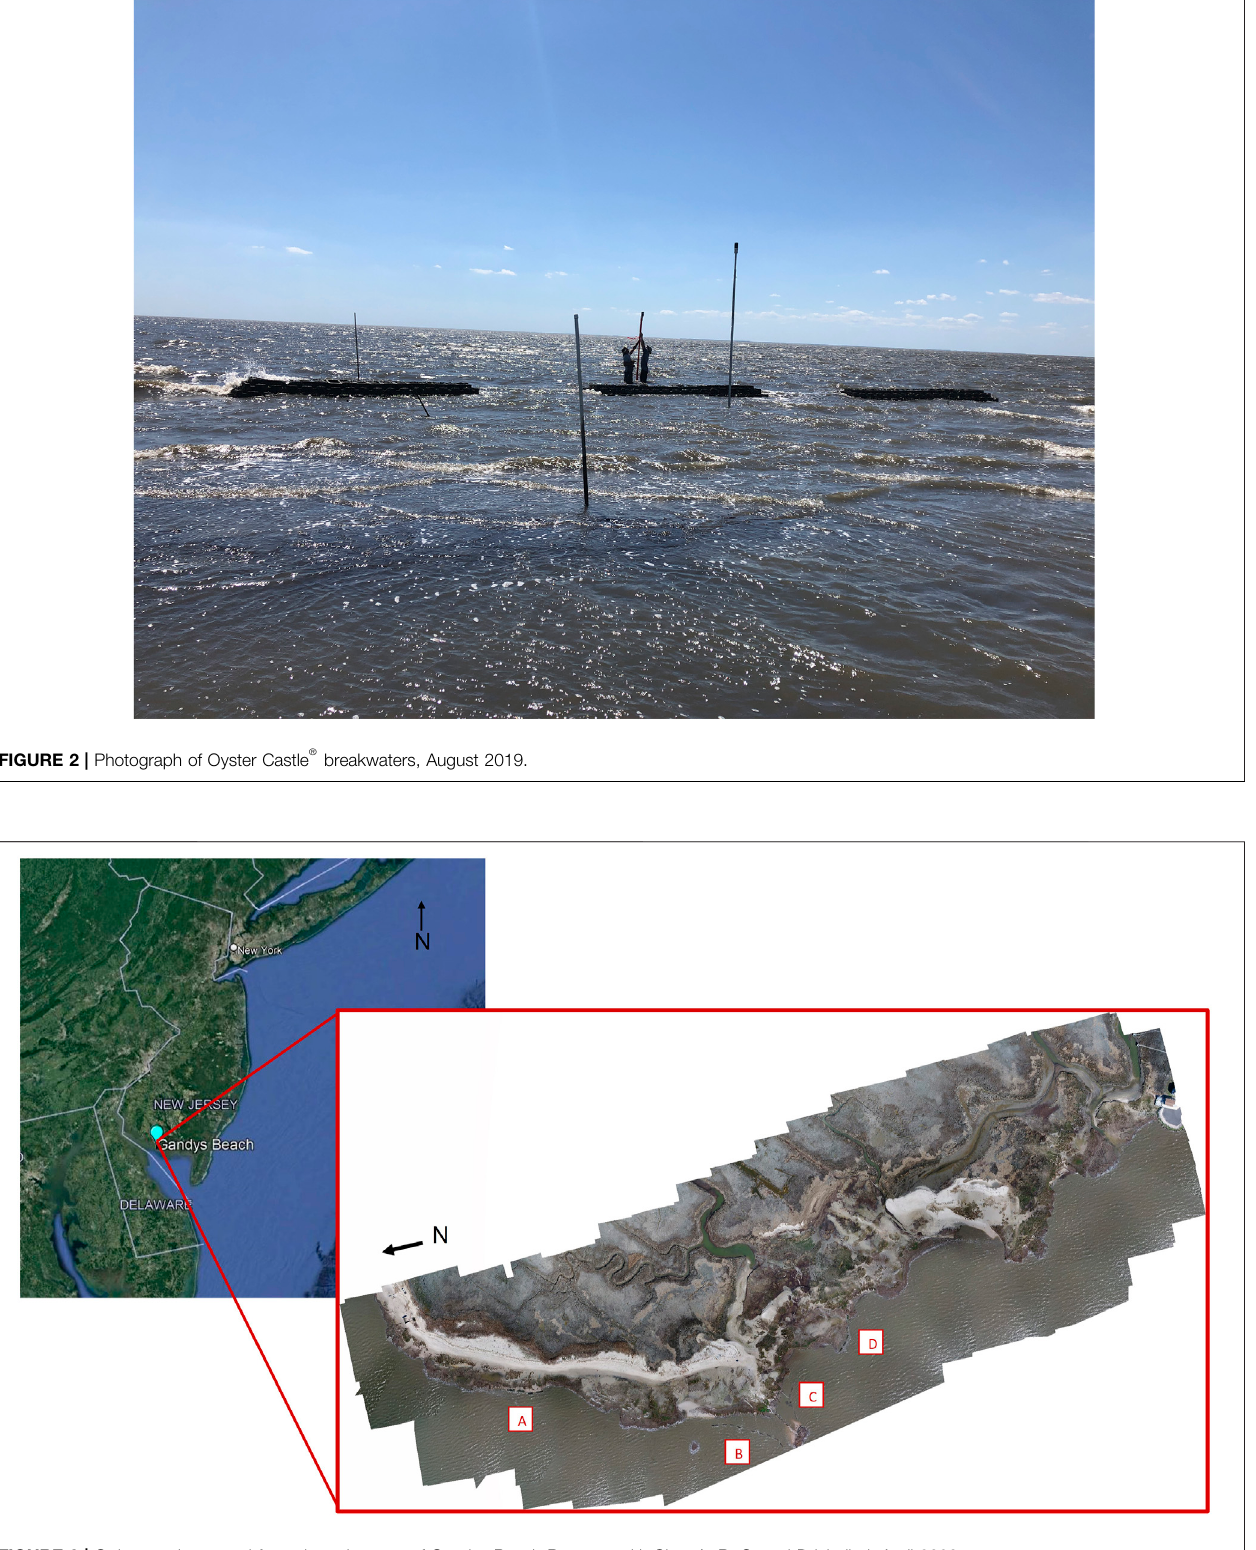
Frontiers in Built Environment |